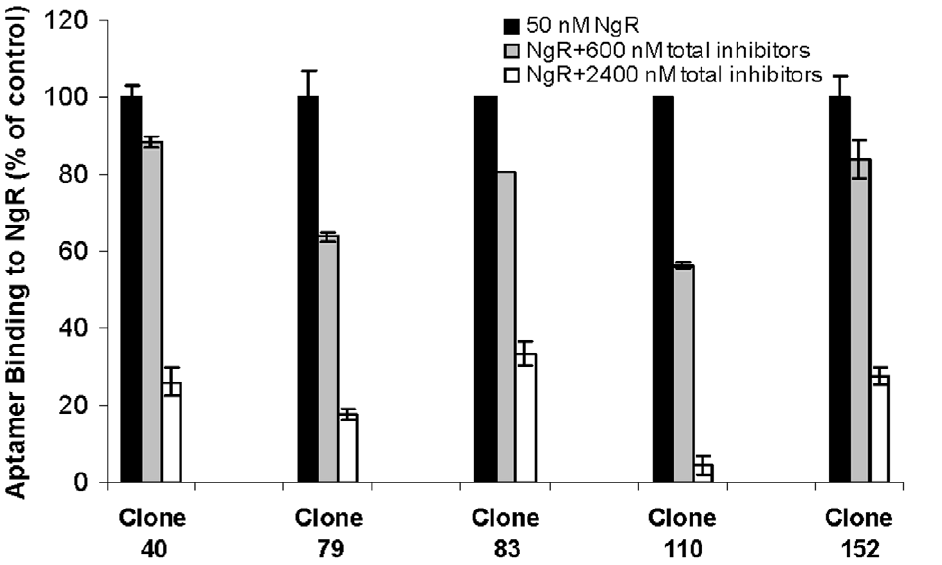
Figure 1. Competition assay between aptamers and myelin-derived inhibitors. The three myelin-derived inhibitors (Nogo, MAG, OMgp) at excess concentrations (200 or 800 nM for each of the three inhibitors, implying 600 and 2400 nM total inhibitor concentrations) reduced aptamer (5 nM) binding to NgR (50 nM) in a standard assay. Results were normalized to the aptamer alone controls. Binding data is the average of two